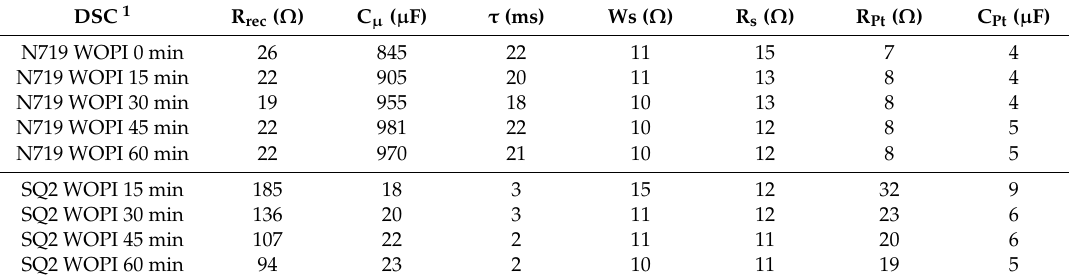
Table 1. The EIS parameters for the DSCs with N719 and SQ2 dyes. The DSCs were measured without preirradiation (WOPI).